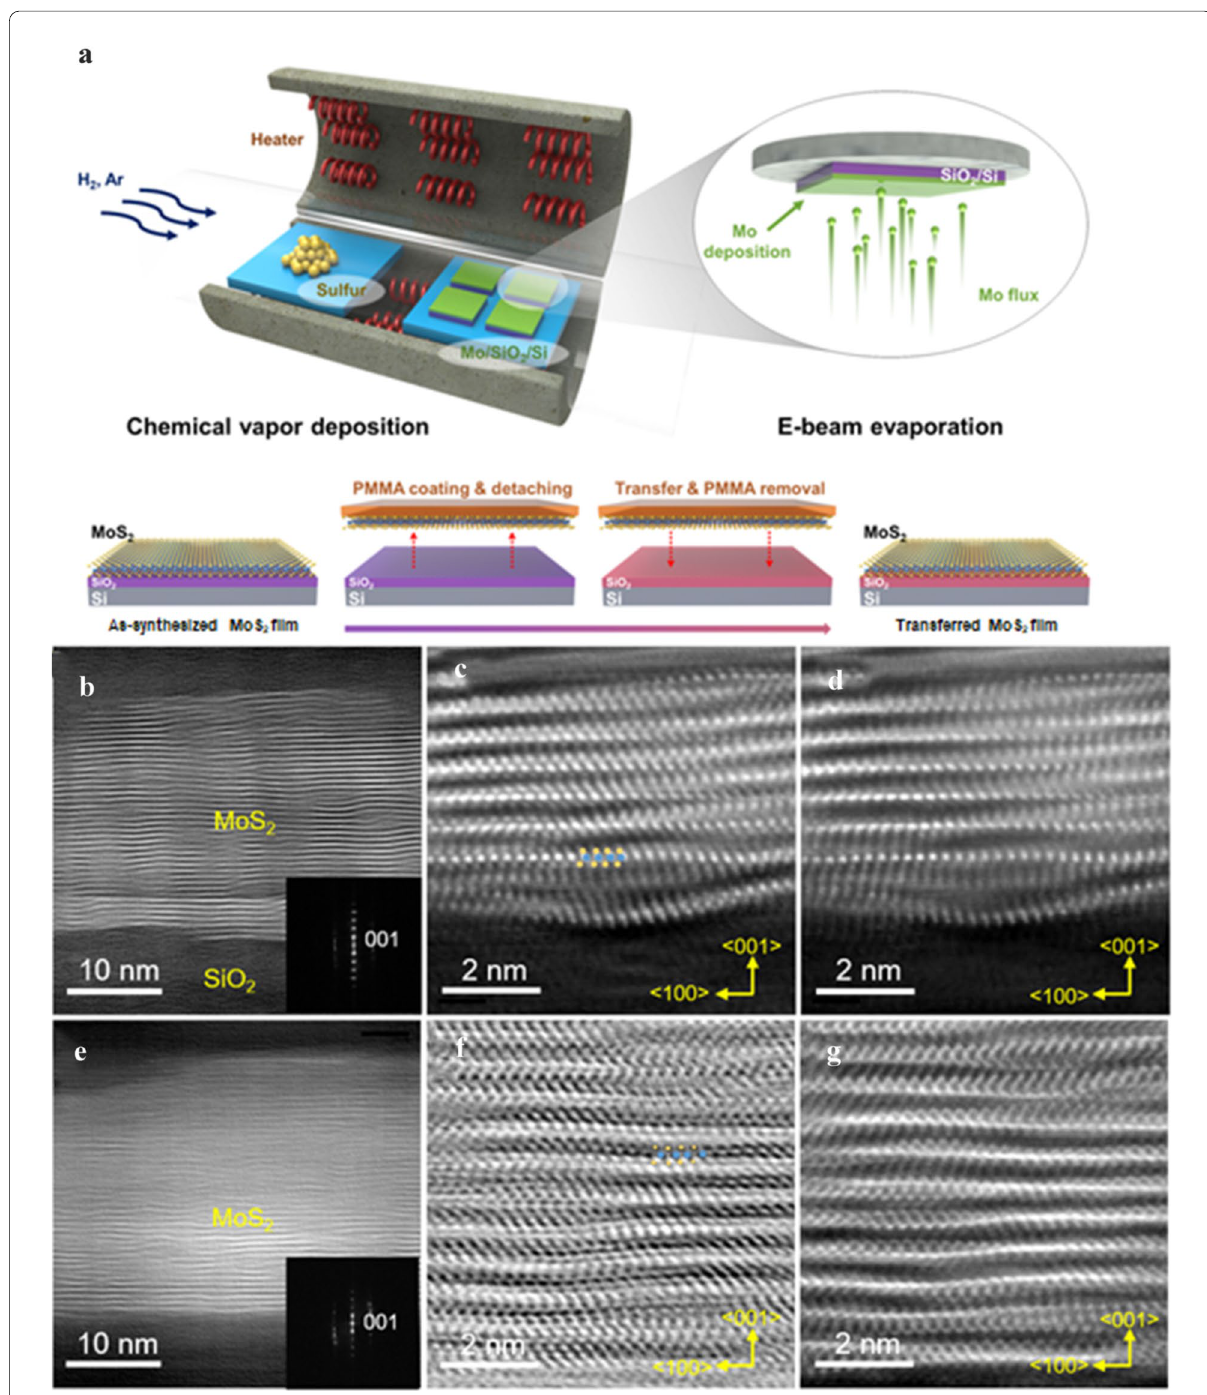
Fig. 1 a Schematic illustration of the MoS 2 film deposition and transfer. STEM images of MoS 2 film on SiO 2 /Si. b Low-magnification HAADF STEM, c Cs-corrected ABF STEM, and d Cs-corrected HAADF STEM images of AS-MoS 2 film. e Low-magnification HAADF STEM, f Cs-corrected ABF STEM, and g Cs- corrected HAADF STEM images of TR-MoS 2